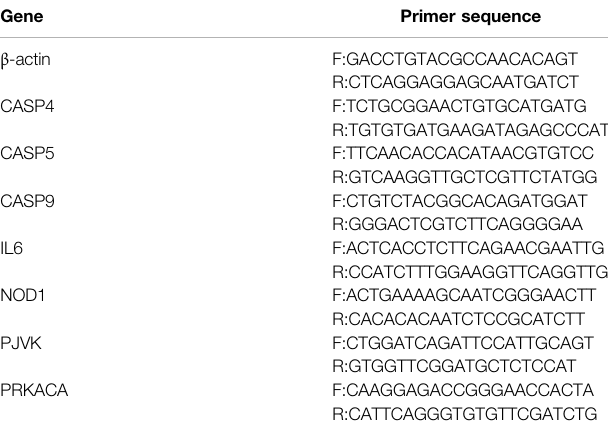
qPCR, quantitative real-time polymerase chain reaction.